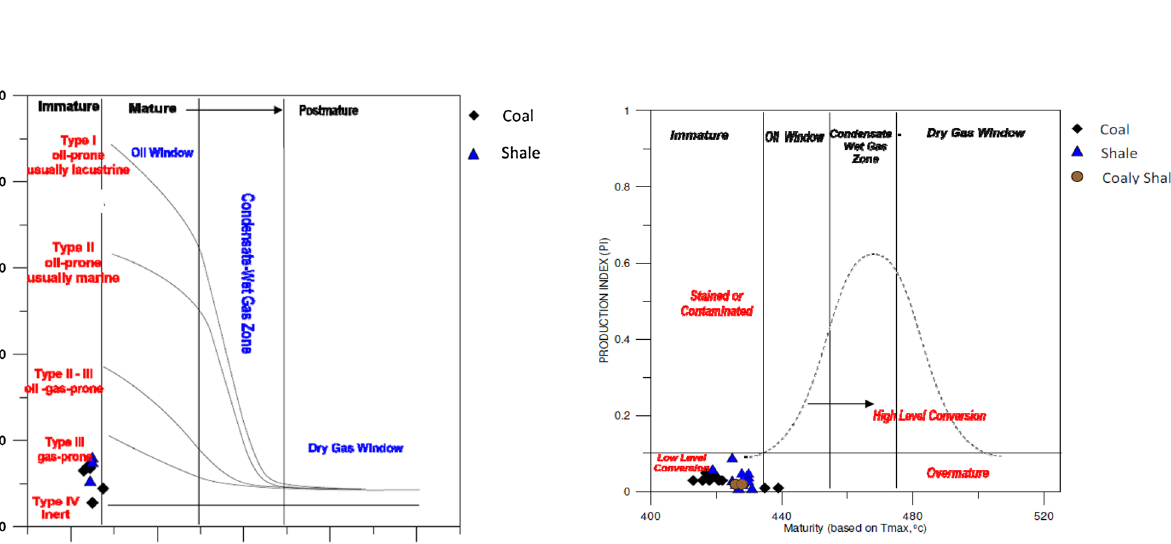
Fig. 11 Plot of production index (PI) against T max of coal, coaly shale and shale samples from Maiganga mine, Gongola Basin. All the sam- ples are immature and have low level conversion of kerogen to